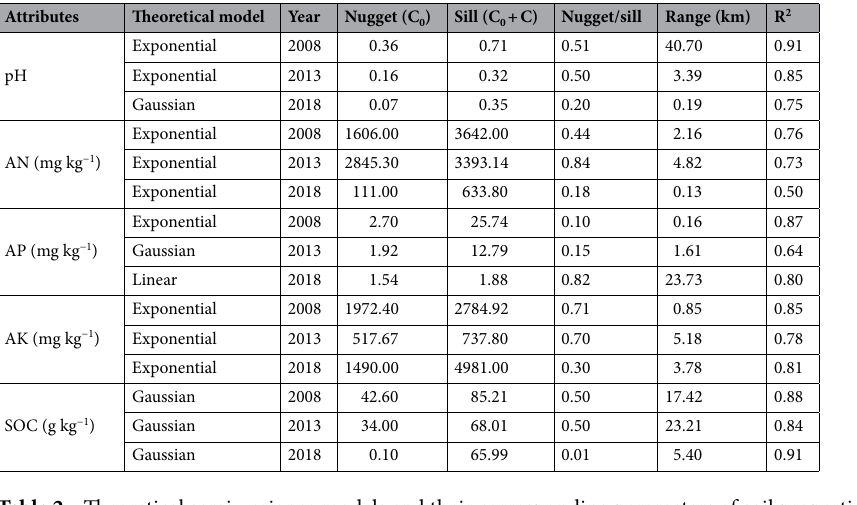
Table 2. Theoretical semi-variance models and their corresponding parameters of soil properties in 2008, 2013 and 2018. AN available nitrogen, AP available phosphorus, AK available potassium, SOC soil organic